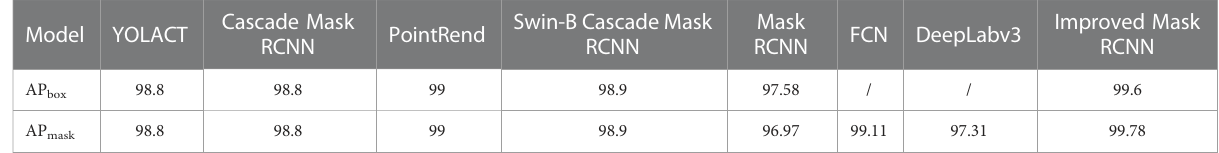
TABLE 2 Detection and segmentation performance of different models on tapped area in test set.